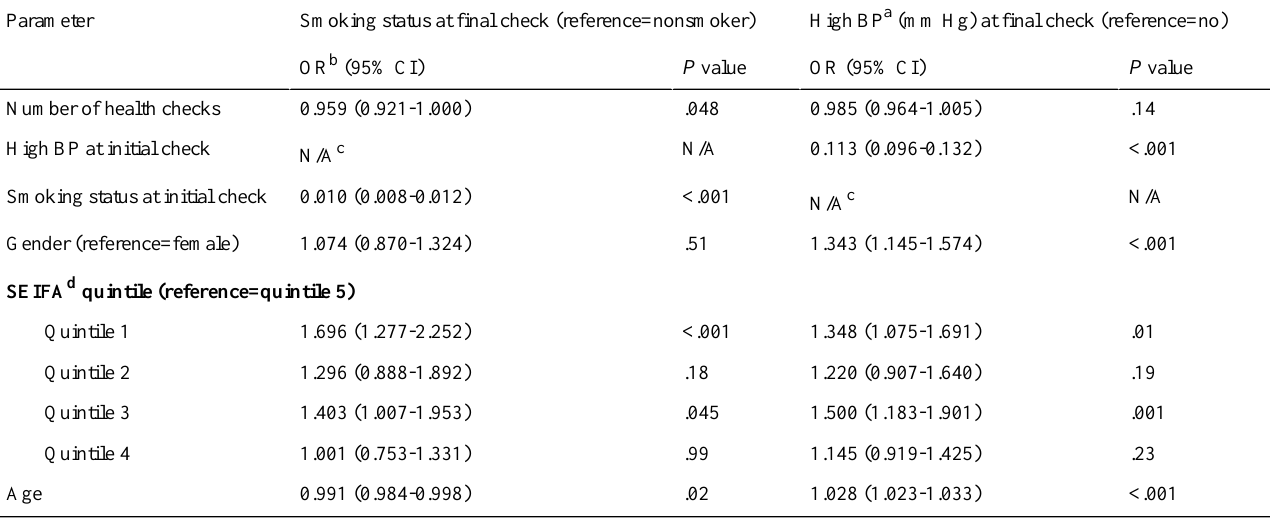
Table 7. Binary logistic regression models explaining the effect of number of health checks on smoking status and high blood pressure status at final